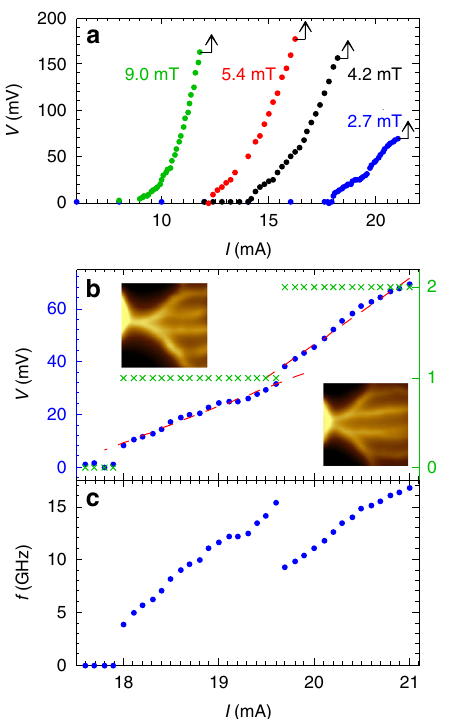
Fig. 3 Current-voltage-frequency characterization of vortex penetration. a Voltage V across the microbridge as a function of current I for various indicated fi elds. b Voltage across the bridge ( blue ) and the number of vortex stems n ( green ) as a function of current at B a = 2.7 mT. The red dashed lines are linear fi ts with d V /d I = 13.9 m Ω in the single stem and 25.1 m Ω in double stem regions. The insets show zoomed-in SOT images of single stem and double stem vortex fl ow. c Vortex penetration rate f per stem vs. current